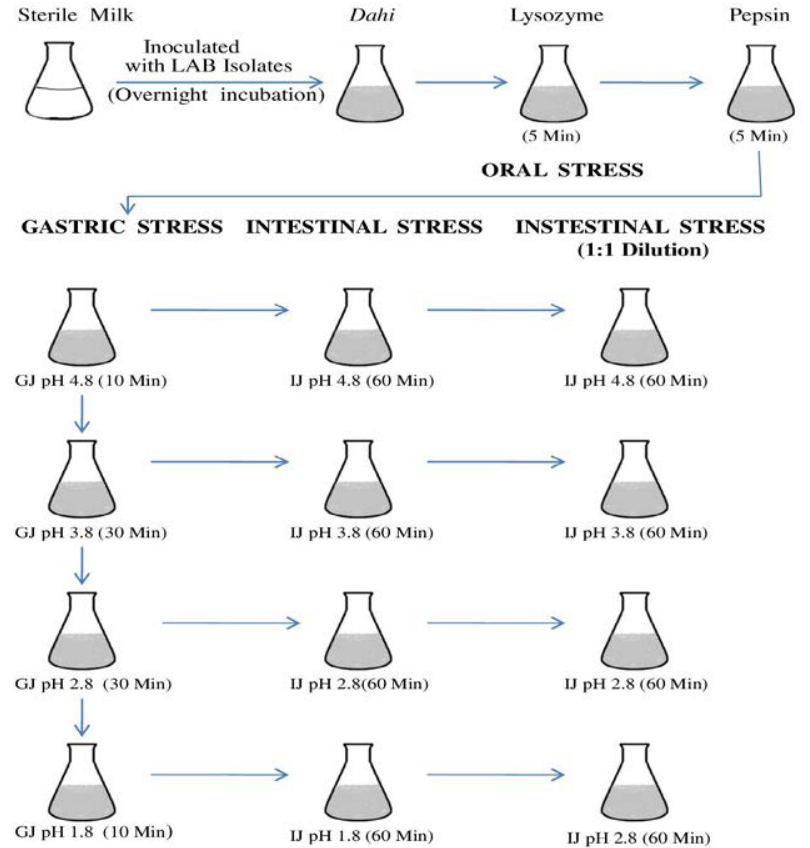
Fig. 1. Flow chart showing the plan for oro-gastric-intestinal stress. Time of incubation after each stress is indicated in the parenthesis and all incubations were carried at 37°C. Each pH stress was followed by intestinal stress. GJ, gastric juice; IJ, intestinal